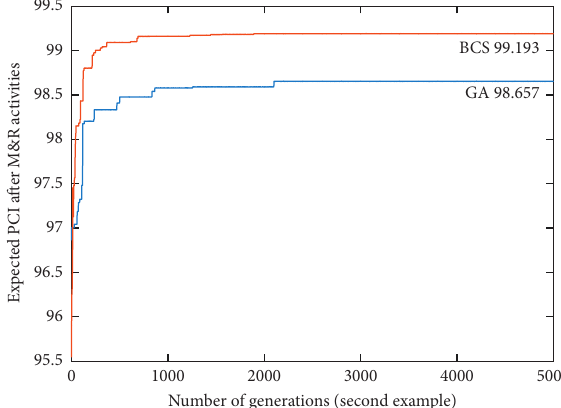
Figure 6: Convergence curve of expected PCI after M&R activities.